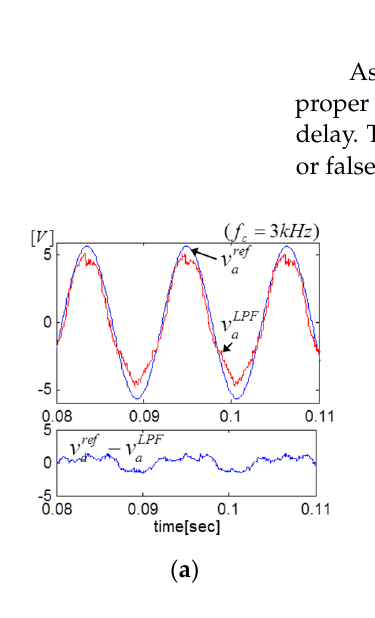
( c ) Figure 12. Voltage measurement-based open-switch fault detection: ( a ) detection concept; ( b ) de- tection results at higher load conditions; and ( c ) detection results at lighter load conditions. Table 2. Parameters and specifications of an AC drive system. Parameters